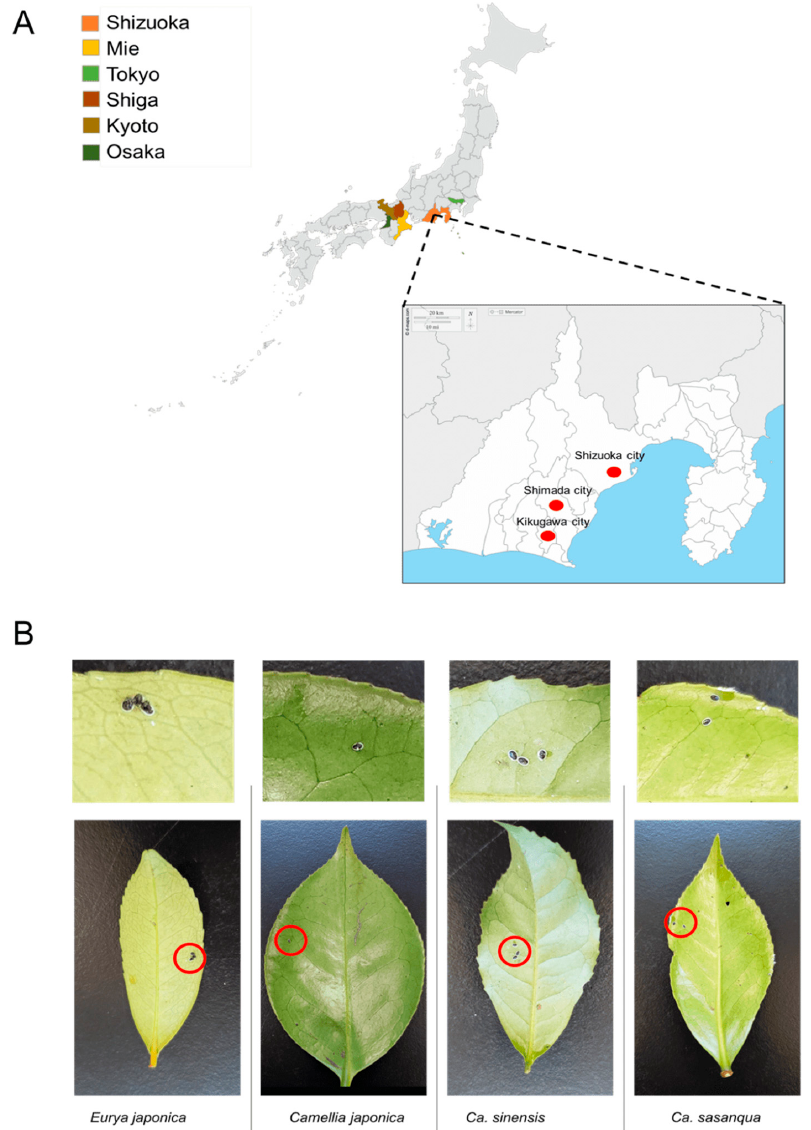
Figure 1. Sample collection: ( A ) sampling sites; ( B ) representative samples of Camellia spiny whitefly and A. camelliae nymphs for molecular assessment.